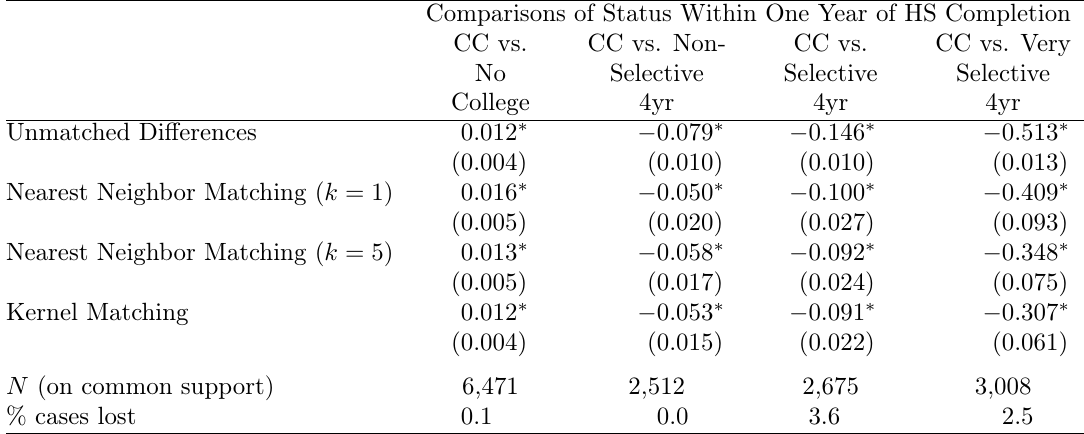
Table 3: Matching Estimates of Community College Attendance on College Completion Comparisons of Status Within One Year of HS Completion CC vs. CC vs. Non- CC vs. CC vs. Very No Selective Selective Selective College